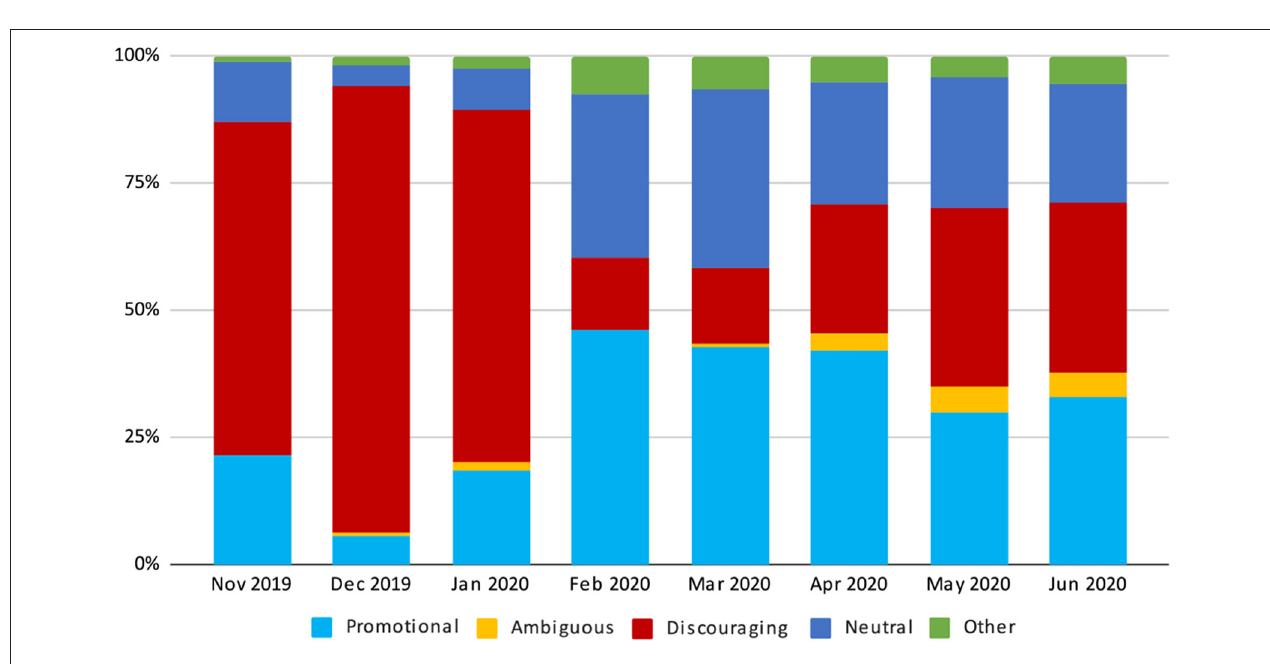
FIGURE 2 | Monthly distribution of the tweets’ vaccine stance in the study period.